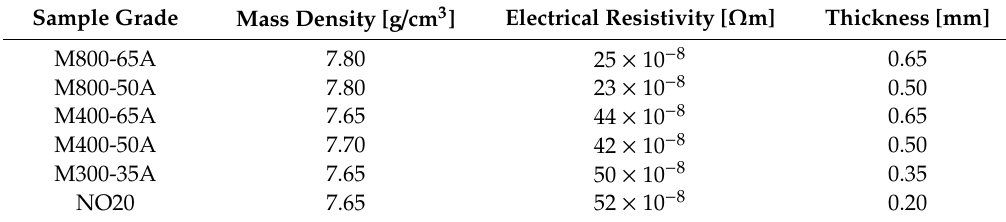
Table 1. Physical and geometrical properties of the investigated non-oriented electrical steels [28].